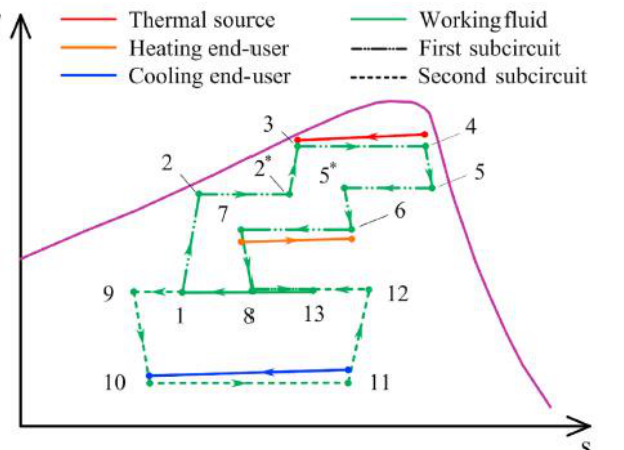
Figure 10. T – s diagram of innovative CCHP cycle enabled by two-phase machines [29]. Two-phase expanders can also be used in the high-temperature heat pumps, consti- tuted by two (top and bottom) vapor compression cycles (Figure 11). In particular, in the evaporator of the bottom cycle, the working fluid (ammonia) receives low-temperature thermal power from a heat source. In the condenser of the top cycle, the working fluid (water) supplies the end-user with high-temperature thermal power. The bottom cycle transfers thermal power to the top cycle in the common heat exchanger. A two-phase screw expander is used in lieu of the throttling valve in each top cycle and bottom cycle [30].